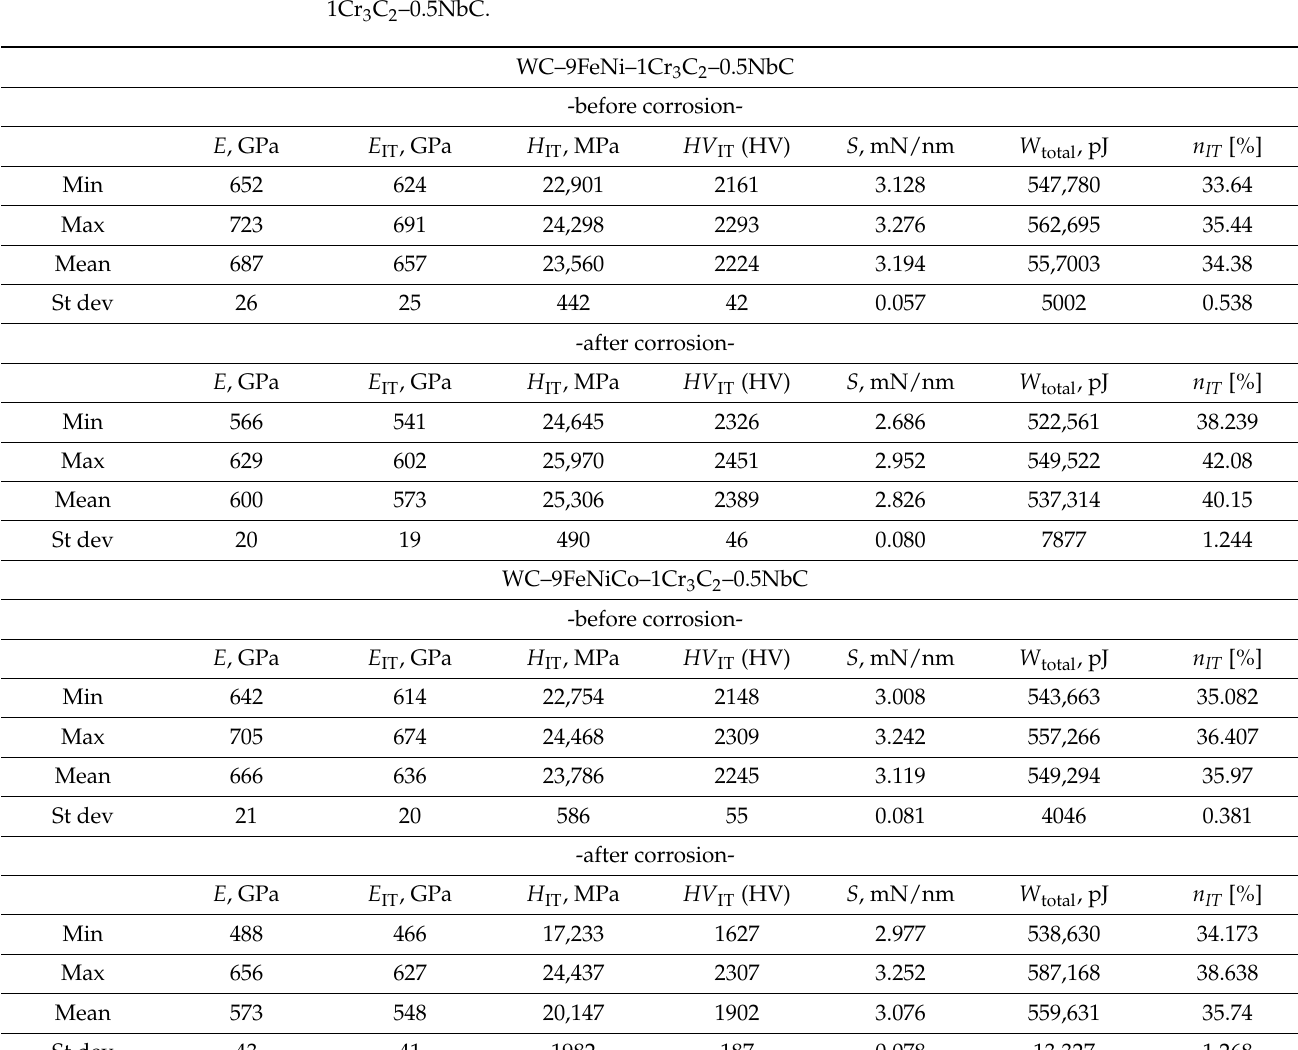
Table 8. Instrumented indentation test results for WC–9FeNi–1Cr 3 C 2 –0.5NbC and WC–9FeNiCo– 1Cr 3 C 2